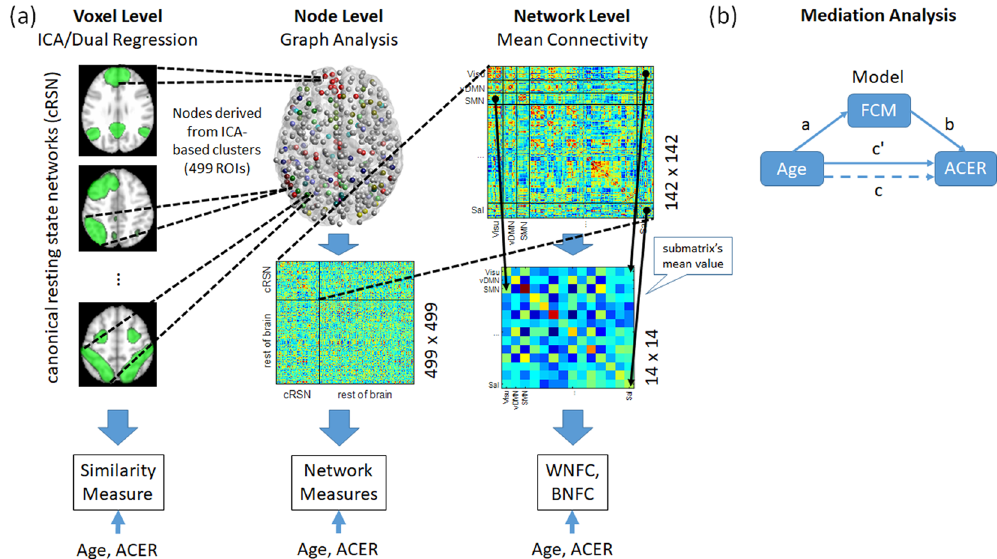
Figure 1. Outline of the overall analysis approach. ( a ) At the voxel level, we used group independent component analysis to extract large-scale canonical resting state networks (cRSNs) from resting state fMRI data and dual regression analysis to identify individual cRSNs. A similarity measure was then estimated for each cRSN relative to a reference RSN. Using clusters derived from cRSNs and the rest of the brain as nodes, we then examined at the node level how the changes observed at the voxel level affected the network properties of the brain using graph analysis. For this, we estimated several whole brain network measures including path length, global efficiency, and degree, among others. Finally, we focused our analysis on the nodes of well-known cRSNs and computed mean connectivity values within cRSNs (within-network functional connectivity, WNFC) and between cRSNs (between-network functional connectivity, BNFC) to investigate changes at the network level. For all estimated measures at all levels, we investigated the measures’ association with age and ACE-R total score. ( b ) For functional connectivity measures (FCM) that showed significant correlation ( p < 0.05, uncorrected) with both age and ACE-R total score, we further performed mediation analysis to elucidate the relationship among the interacting variables. The mediation model shown in ( b ) was used. Details of the methods used in the analysis are given in the Methods